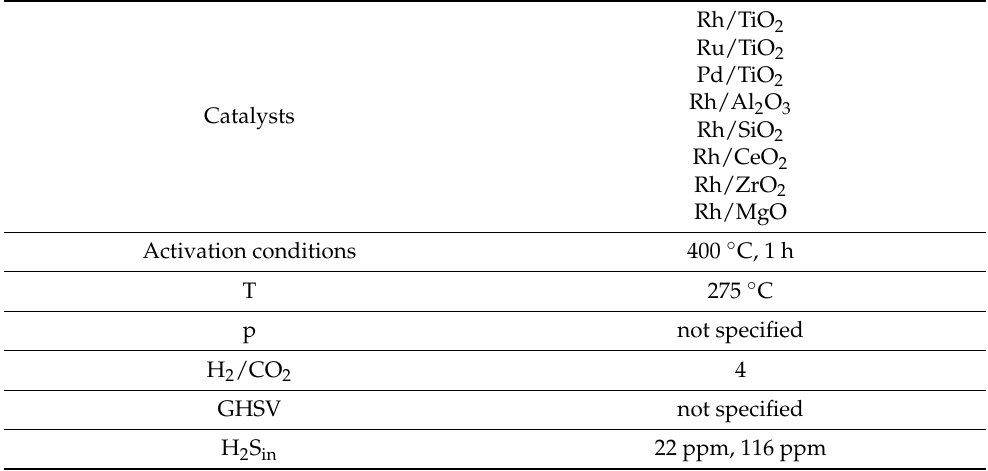
Figure 8. CO 2 conversion in H 2 S poisoning experiments in methanation with ( a ) 1 ppm H 2 S addition to bimetallic Ru catalysts [69] and ( b ) Rh/TiO 2 [101]. Table 19. Catalysts and reaction conditions for experiments on H 2 S influence in methanation with noble metals on different supports